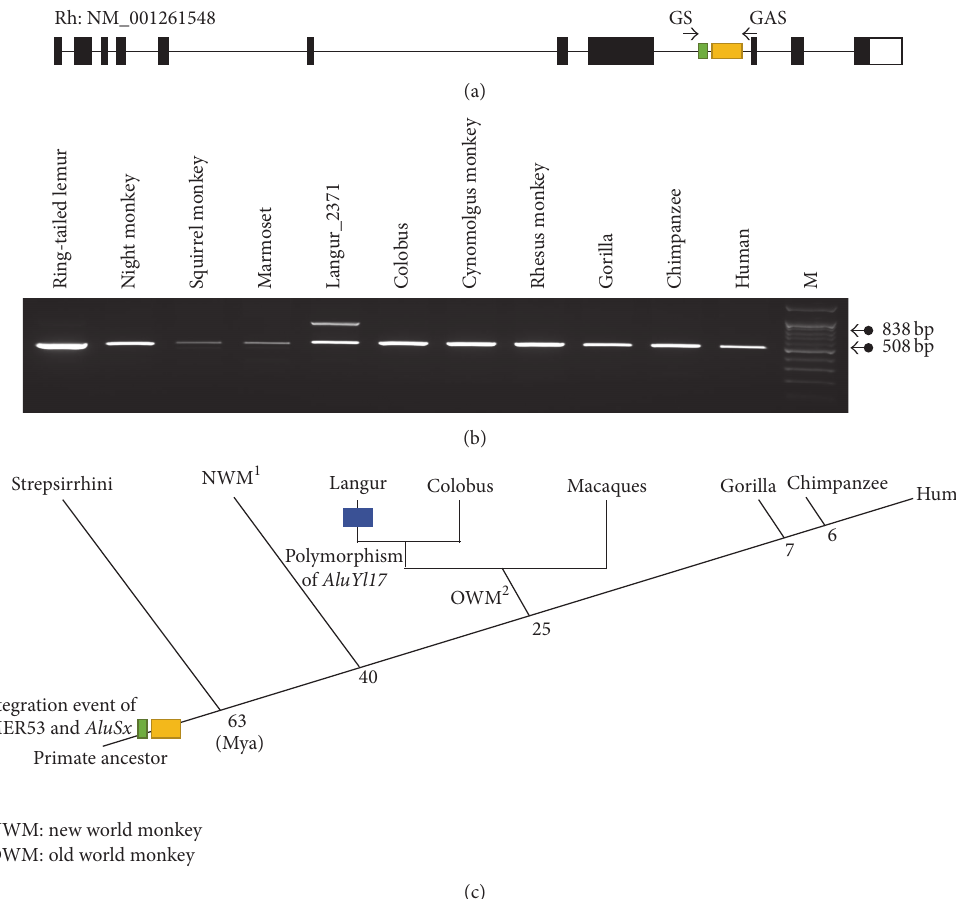
Figure 5: Evolutionary investigation of MER54 and AluSx element during primate evolution. (a) Genomic structure of rhesus monkey TSEN54 gene and primer location. (b) PCR amplification of MER54 and AluSx with various primate DNA samples. M indicates the size marker. (c) Schematic representation of the integration events of MER54 and AluSx in TSEN54 during primate evolution. Mya: millions of years